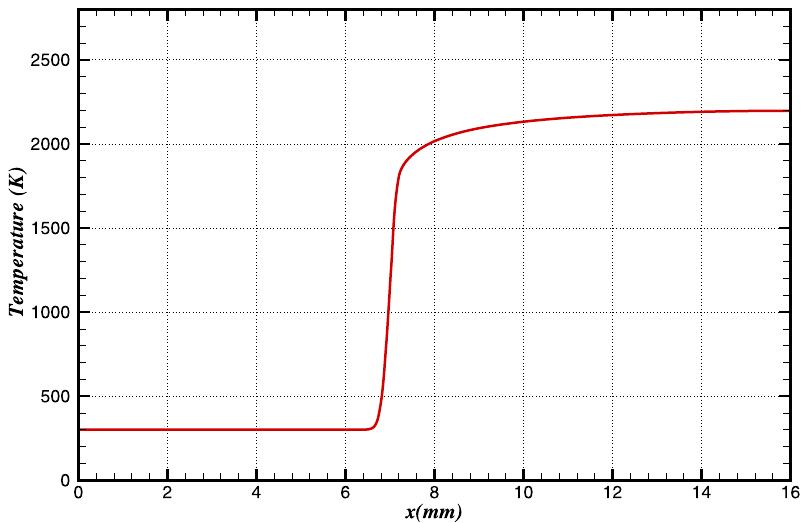
Figure 2. Steady state temperature profile in the domain.